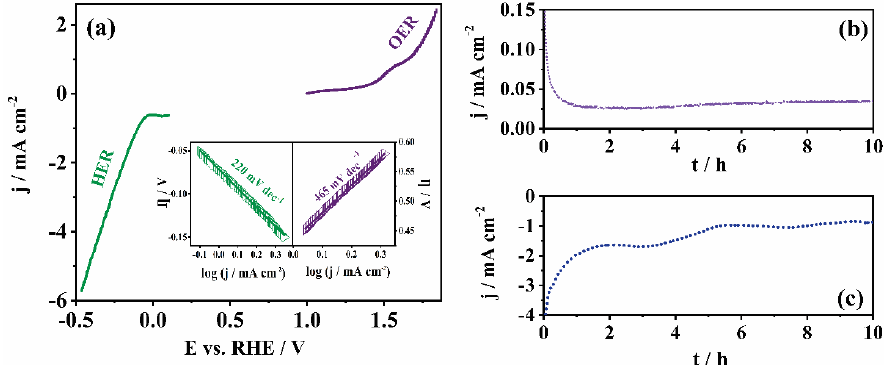
Figure 6. HER and OER polarization curves in 0.5 M H 2 SO 4 with the corresponding Tafel plots in the inset for Mn-CP ( a ). Stability tests under ( b ) OER (constant potential of 1.4 V) and ( c ) HER (constant potential of − 0.5 V) conditions in 0.5 M H 2 SO 4 . Table 2. Comparison of HER and OER parameters of the herein studied catalyst with ( Mn-CP ) literature data a